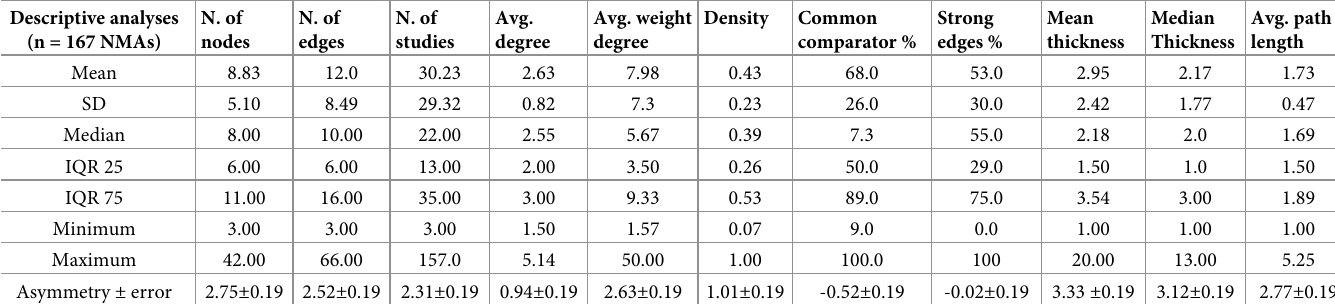
Table 2. Assessment of NMAs geometry. Descriptive analyses (n = 167 NMAs)